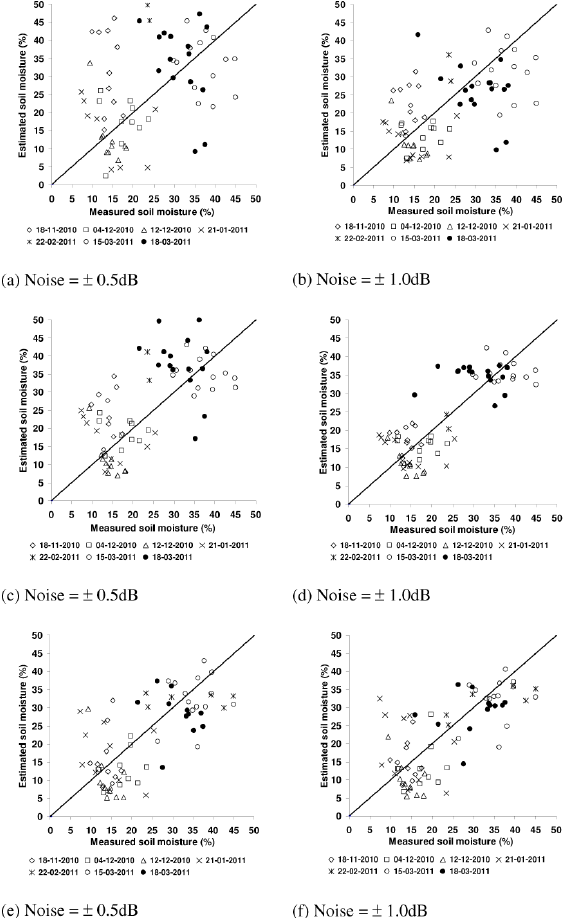
Fig. 4. Retrieved soil moisture versus in situ measurements. (a, b) : without a constraint on mv and rms; (c, d) : with a constraint on mv (expert knowledge); (e, f) : use of α 1 and anisotropy to de- termine the possible values of mv and rms. Each point corresponds to one training plot (using the mean backscattering coefficient of all pixels of the reference plot). The reference plots are at the outside of the RADARSAT-2 image of 11 January 2011. The neural networks trained with data generated at incidence angles of 35 ◦ and 45 ◦ were used for images acquired at incidence angles near of 35 ◦ and 45 ◦ , respectively.